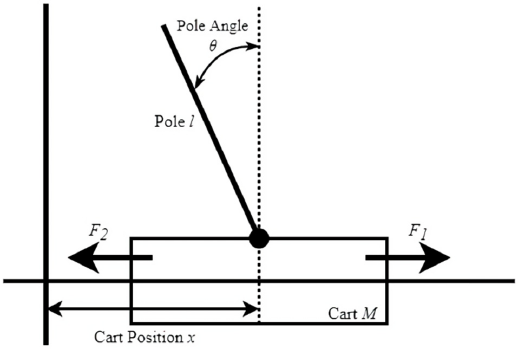
Figure 4. Example of the cart-pole balancing problem environment. Table 1. Environment of the cart-pole balancing problem. Environment Parts